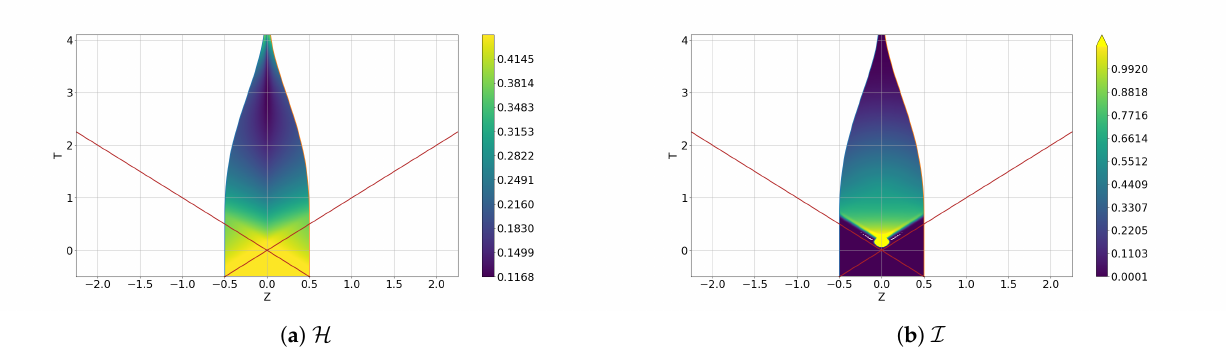
Figure 13. The expansion rate H and Weyl invariant I with a ≈ a 1 and λ = 0.6.